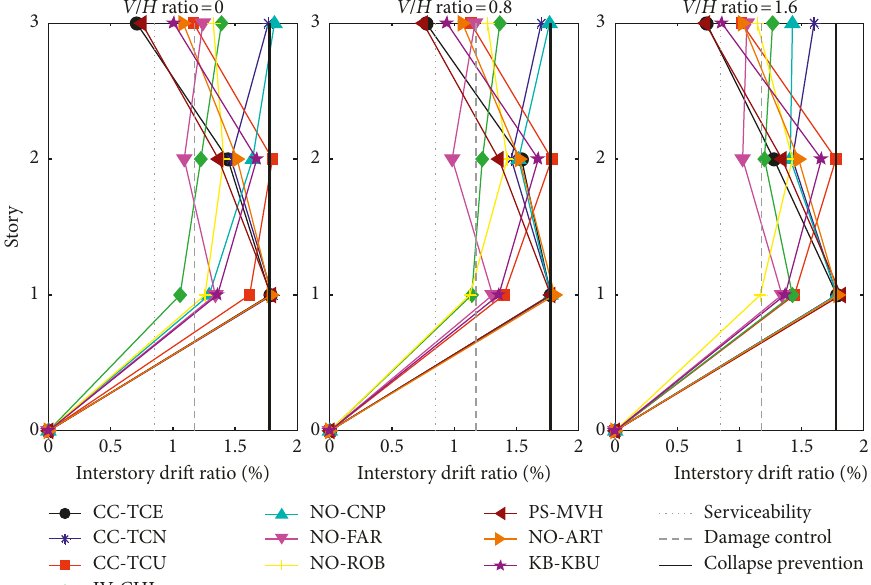
Figure 5: Interstorey drift ratio,